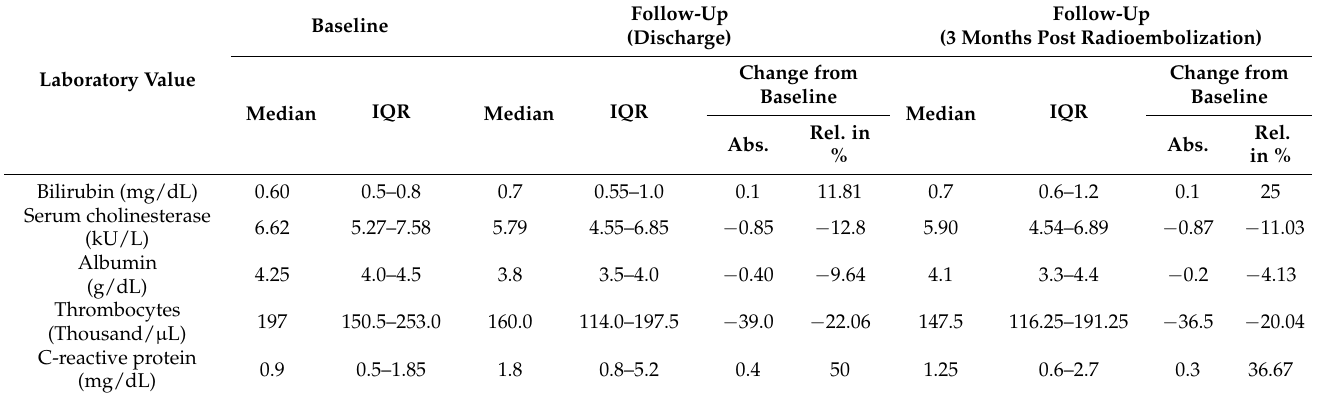
Table 4. Laboratory values at baseline, discharge, and 3 months after